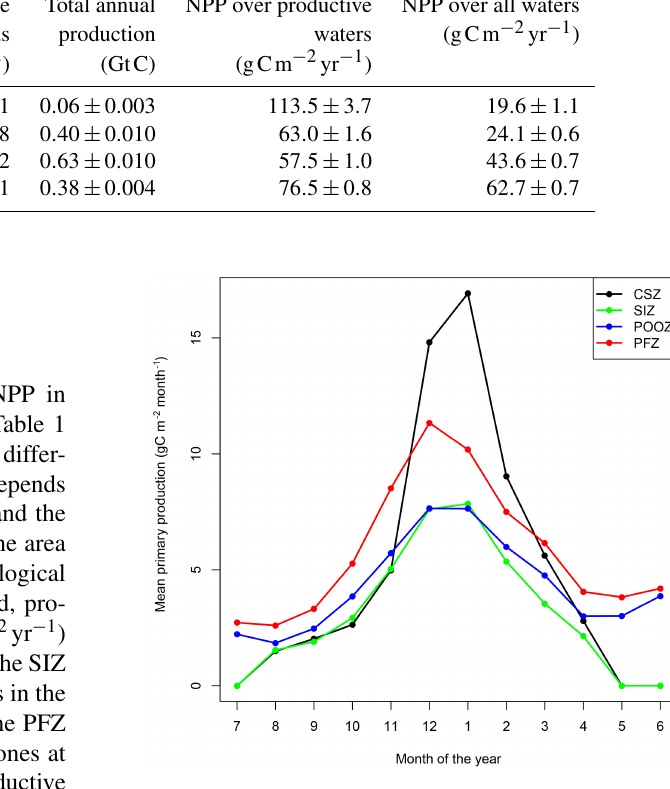
Figure 3. Monthly mean NPP of different ecological zones 2002– 2014.